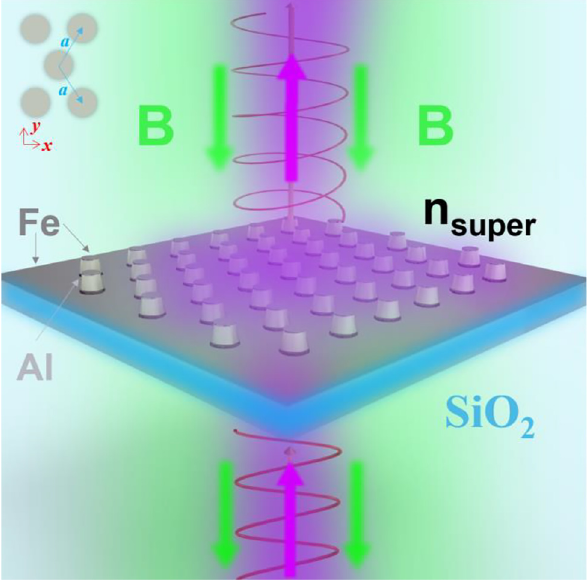
Figure 1: Schematic of Faraday rotation (FR) under the external magnetic field B along z direction on the Al NP hexagonal array with 7.5 nm Fe fi lm on the top with different superstrates of refractive index n super . Left-top inset shows the unit cell of hexagonal array withpitch a inthe x-y planeusedinthecalculation.Thesketchofthe Al nanostructure used in the FDTD calculations is provided in Appendix Figure